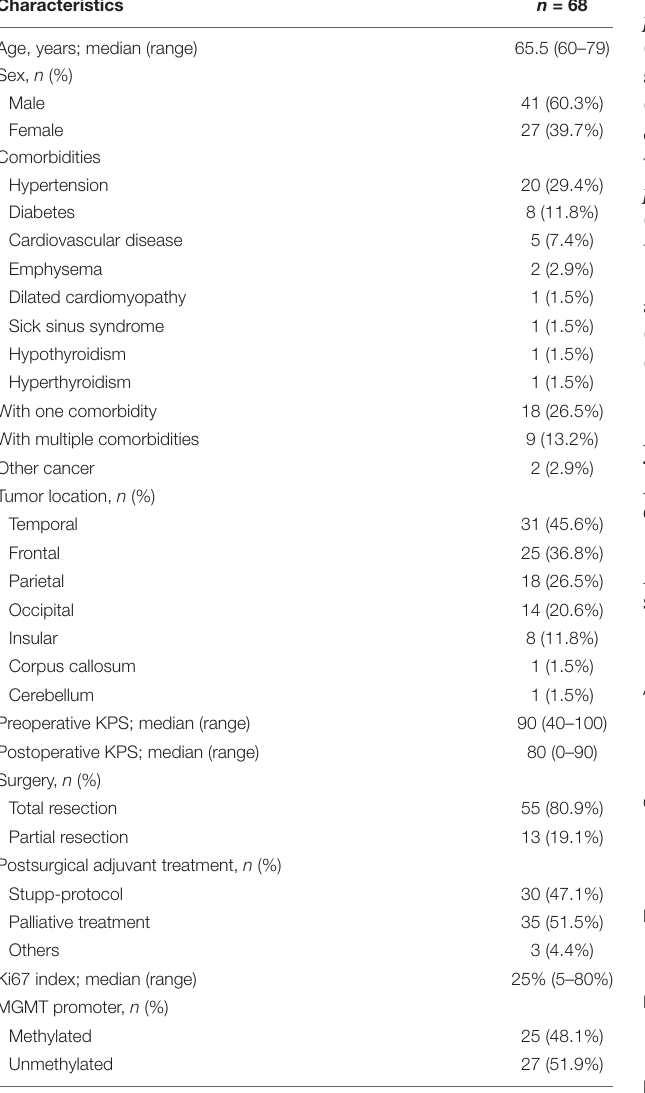
TABLE 1 | Demographic date of all included patients.